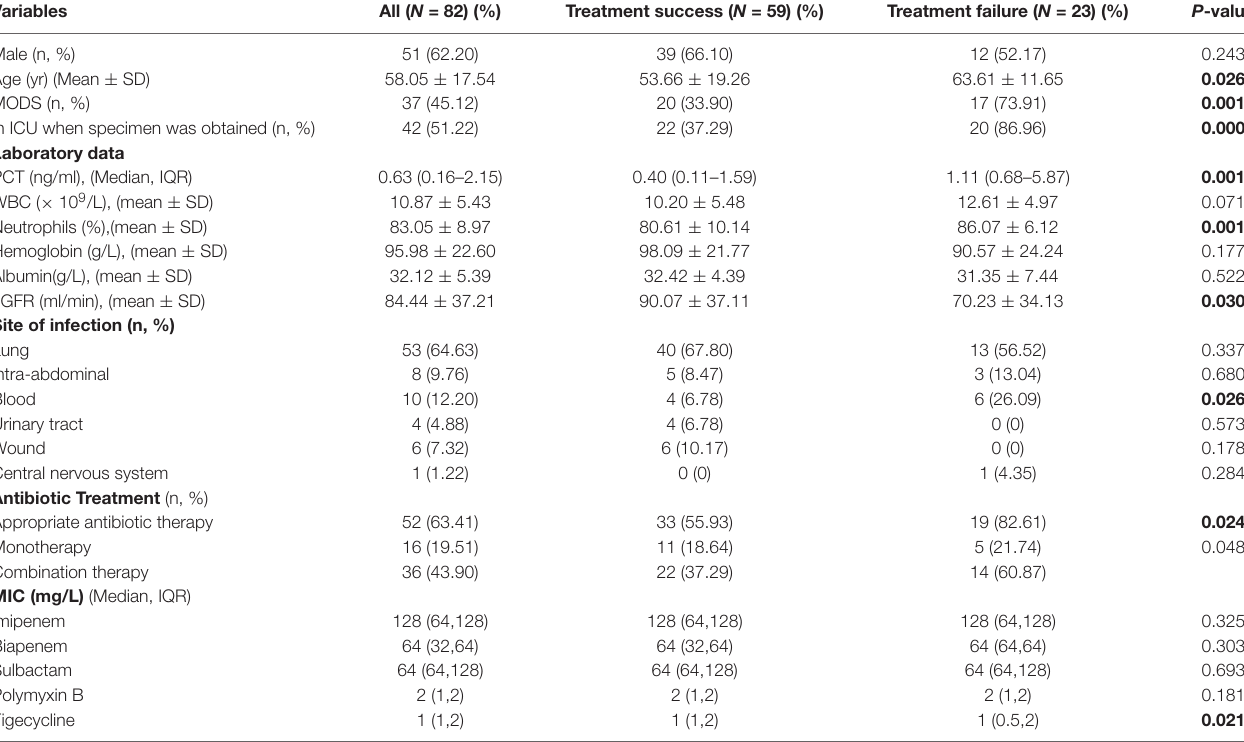
TABLE 4 | Clinical characteristics in patients with carbapenem-resistant Acinetobacter baumannii infection. Variables All ( N = 82)